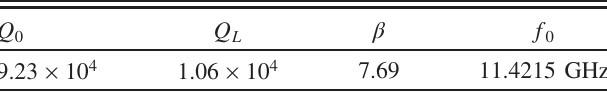
TABLE III. Measured resonator characteristics of spherical cavity ( TE 114 mode).